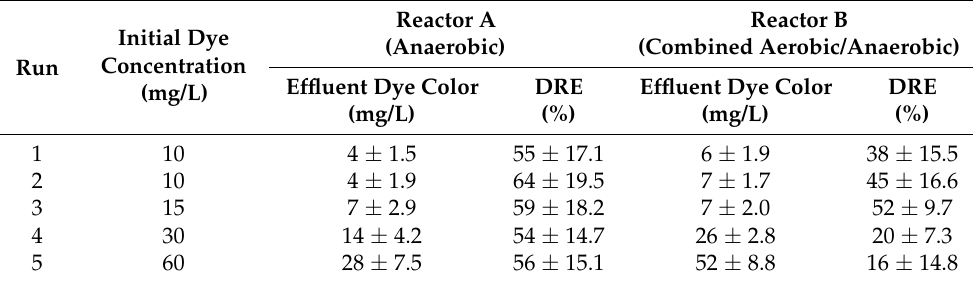
Table 2. The average value of effluent dye concentration and decolorization